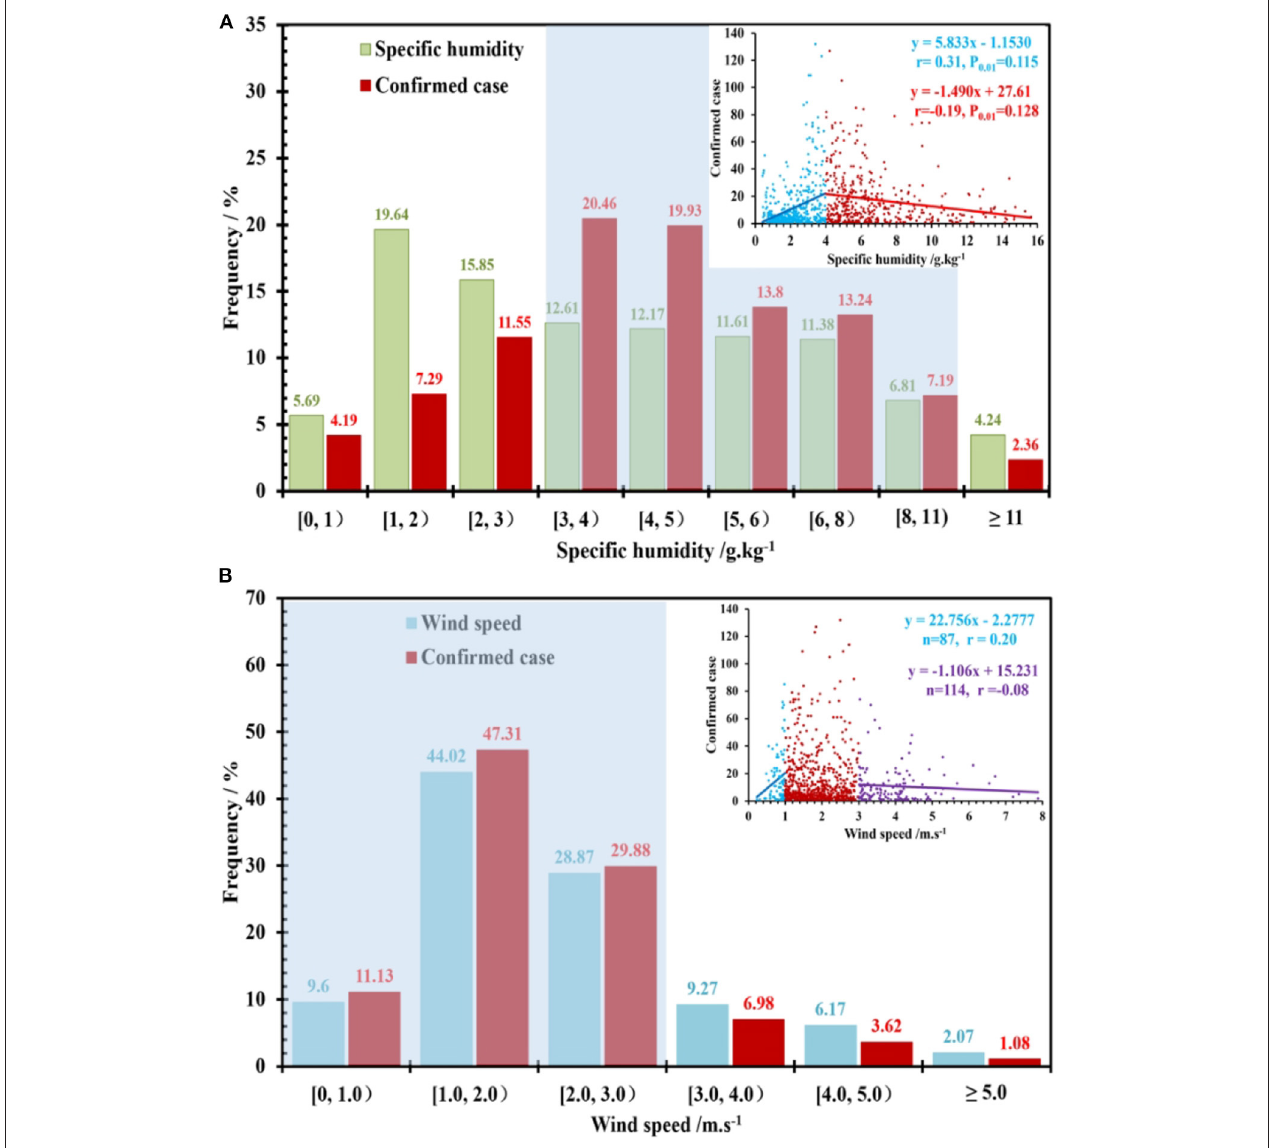
FIGURE 4 | Frequency distribution and linear correlation (inset) between confirmed cases and (A) specific humidity and (B) wind speed.